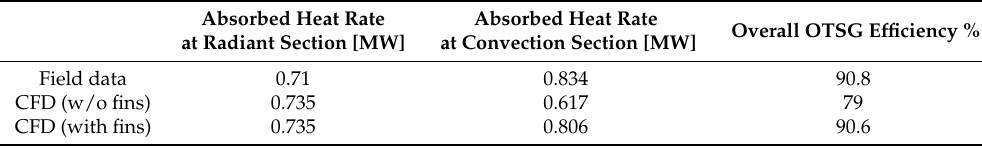
Table 15. Duty distribution and overall OTSG comparison between field datasheet and CFD model.